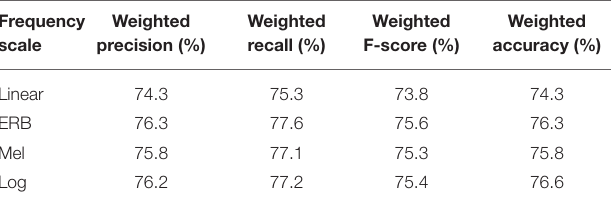
TABLE 5 | Results of Experiment 3—Effect of the µ -low companding on SER, f s = 16kHz.